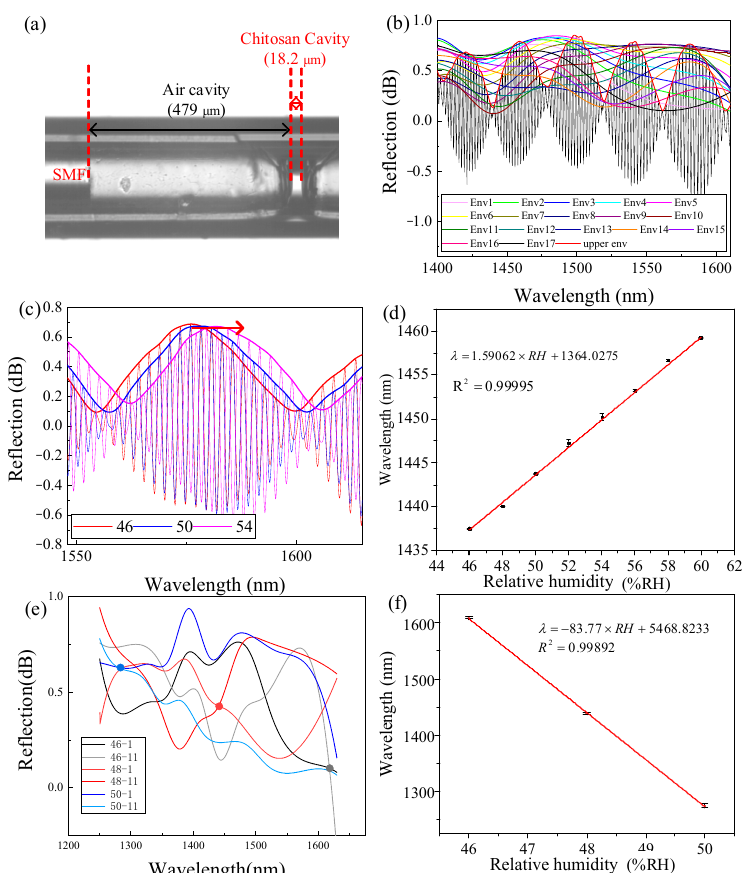
Figure 14. Supplementary experiment results. ( a ) Microscopic image of the sensor; ( b ) inner envelope fitting spectrum; ( c ) spectra of upper envelope change; ( d ) measured wavelength shift vs. RH change of upper envelope; ( e ) spectra of inner envelope change; and ( f ) measured wavelength shift vs. RH change of inner